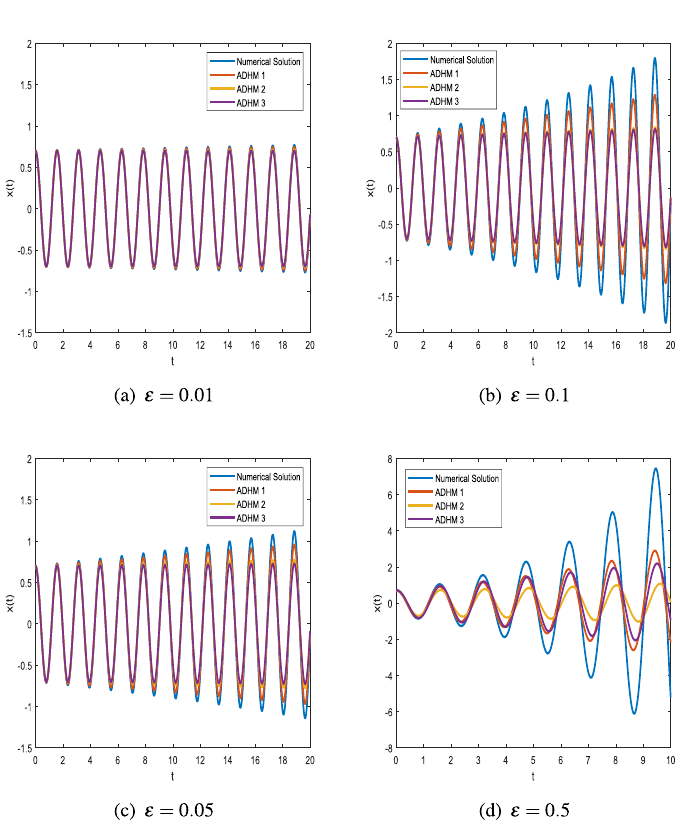
Figure 2. Comparison of ADHM results and numerical solution for parametric values x 0 = 0.7 and ω = 4